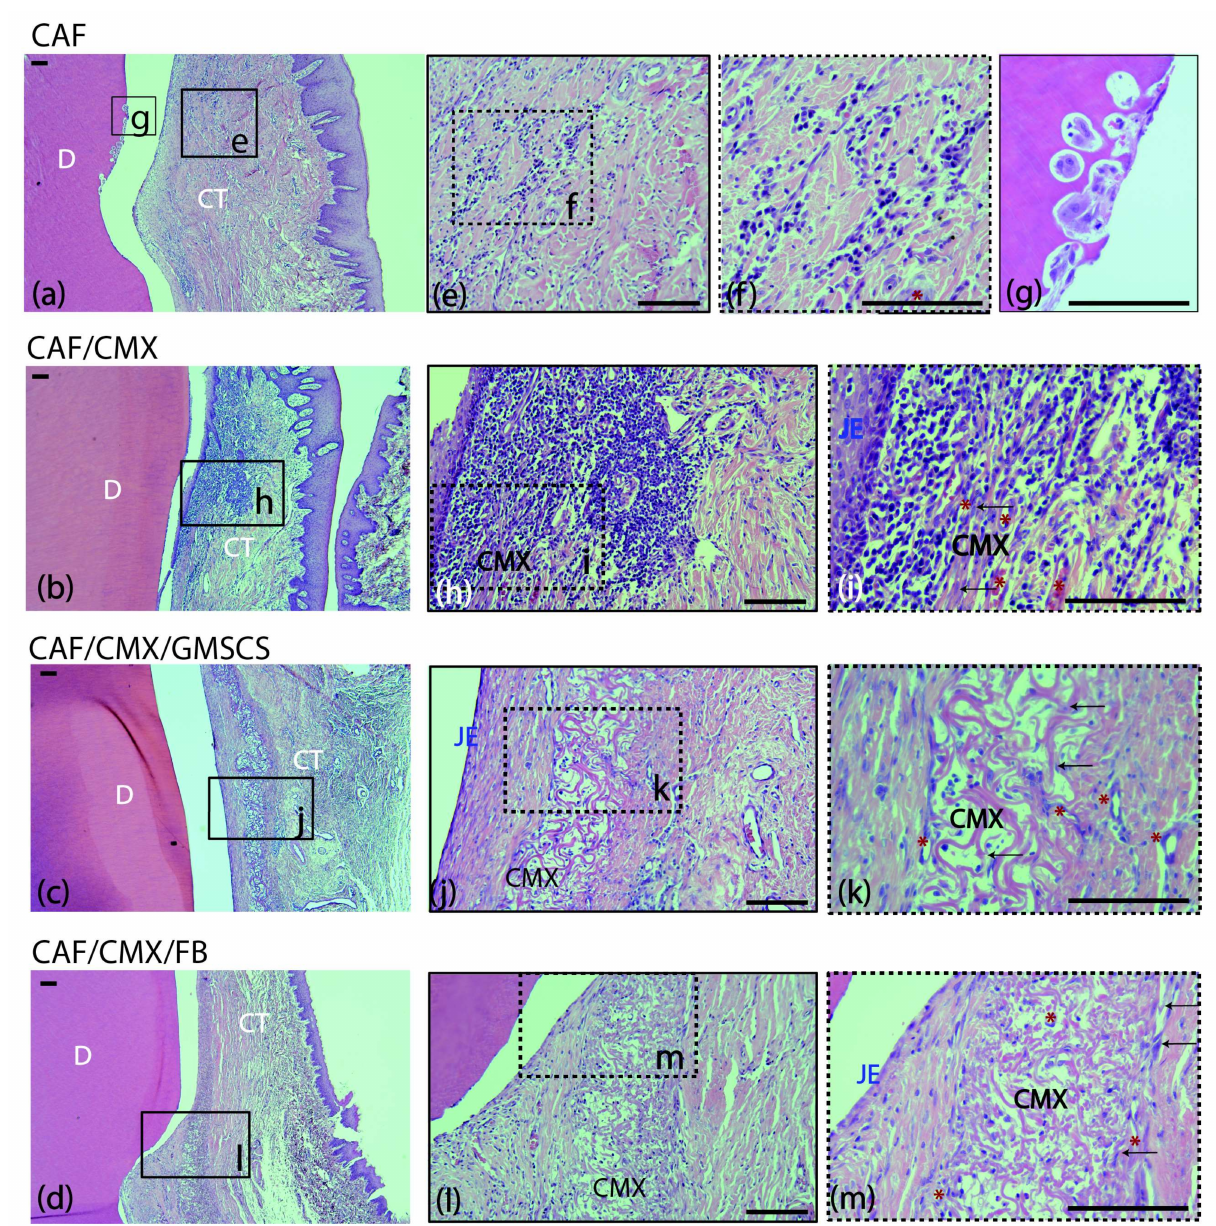
Figure 2. Cross-sections of the buccal dento-gingival area after 2 weeks of healing. Haematoxylin and eosin (HE) stain. ( a – d ) Photomicrographs of the supracrestal periodontal tissues in the four groups. ( e , f ) Mild acute inflammatory infiltrate in the connective tissue in the CAF group. ( g ) Image showing root resorption with presence of osteoclasts in Howship’s lacunae in the same specimen from the CAF group. ( h , i ) Inflammatory infiltrate in the connective tissue surrounding the matrix in the CAF+CMX group. Note the high density of leucocytes and blood channels. ( j , k ) Collagen matrix within the connective tissue with mild inflammatory infiltrate and few fibroblasts in the CAF+CMX+GMSCs group and in the CAF+CMX+FBs group ( l , m ). Please note the lower density of leucocytes in the GMSCs and FBs groups in comparison with the CMX alone group. CAF, coronally advanced flap; CAF+CMX, coronally advanced flap+collagen matrix; CAF+CMX+GMSCs, coronally advanced flap+collagen matrix+gingiva-derived mesenchymal stem cells; CAF+CMX+FB, coronally advanced flap+collagen matrix+fibroblasts; SD, standard deviation; D, dentin; CT, connective tissue; CMX, collagen matrix; JE, junctional epithelium; black arrows, fibroblasts; red asterisks, blood channels. Scale bar = 100 µ